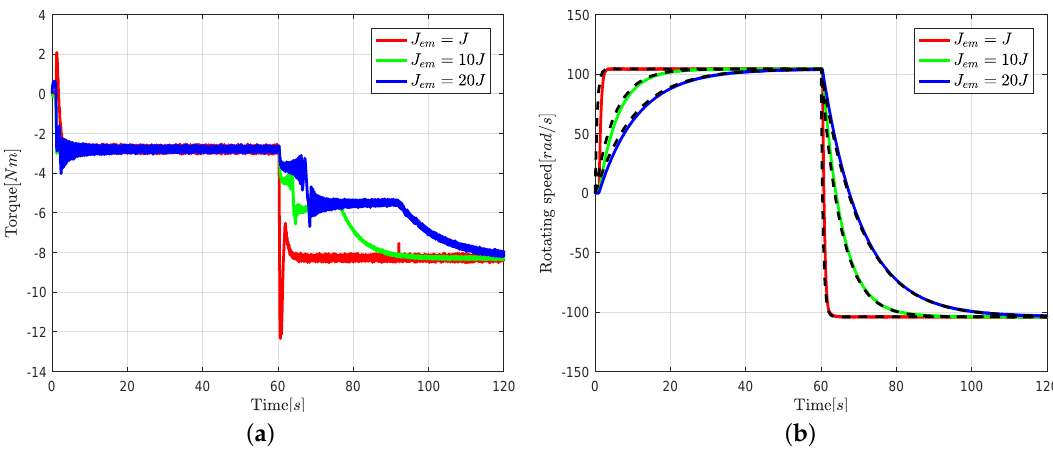
Figure 8. The responses with various dynamic loads to emulate ( B em = 40 B is fixed): T m = 5 u ( t ) Nm and T L = 10 u ( t 60 ) Nm. ( a ) The measurement of the dynamometer torque T e . ( b ) The measurement − of the rotating speed ω m (solid), and the desired one ω em (dashed) obtained by numerical